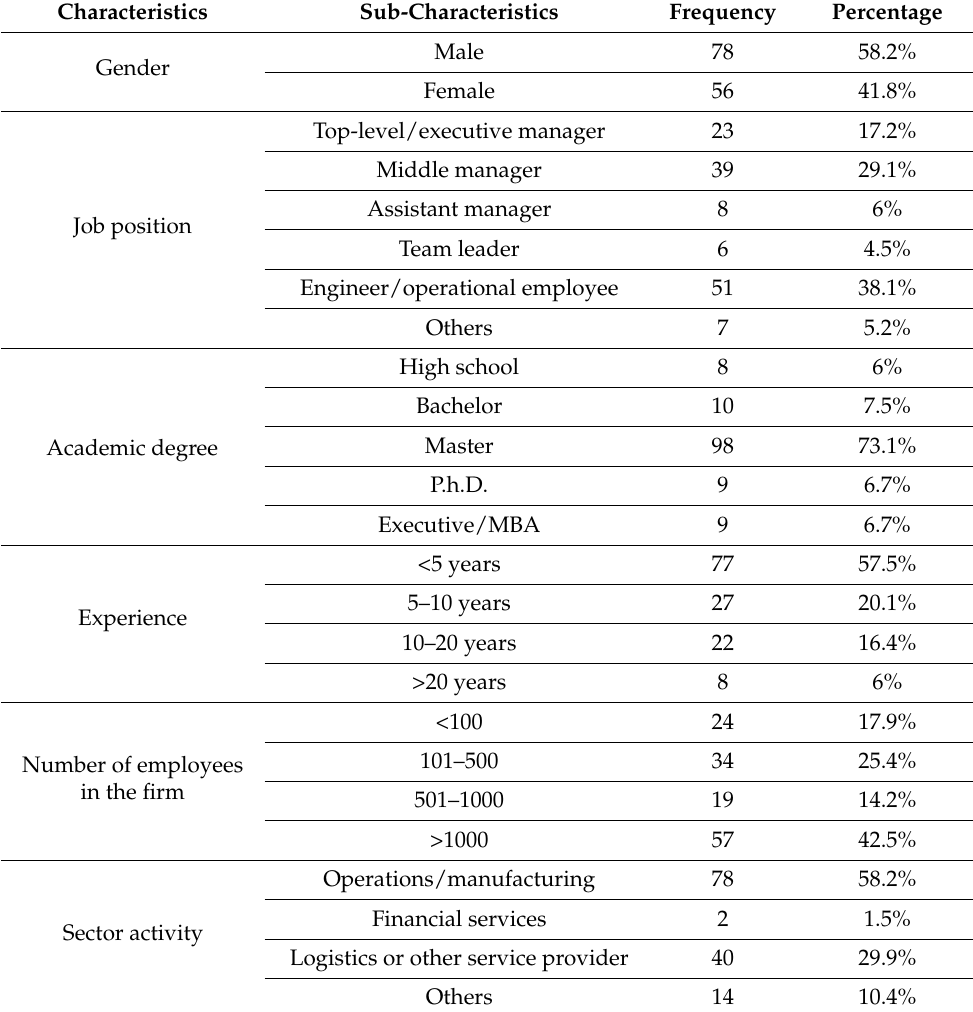
Table 1. Sample characterization of the